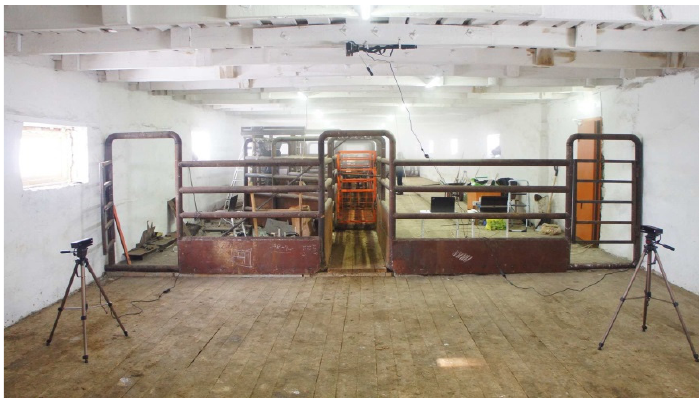
Figure 3. RGB-D image capture system with three Kinect cameras.